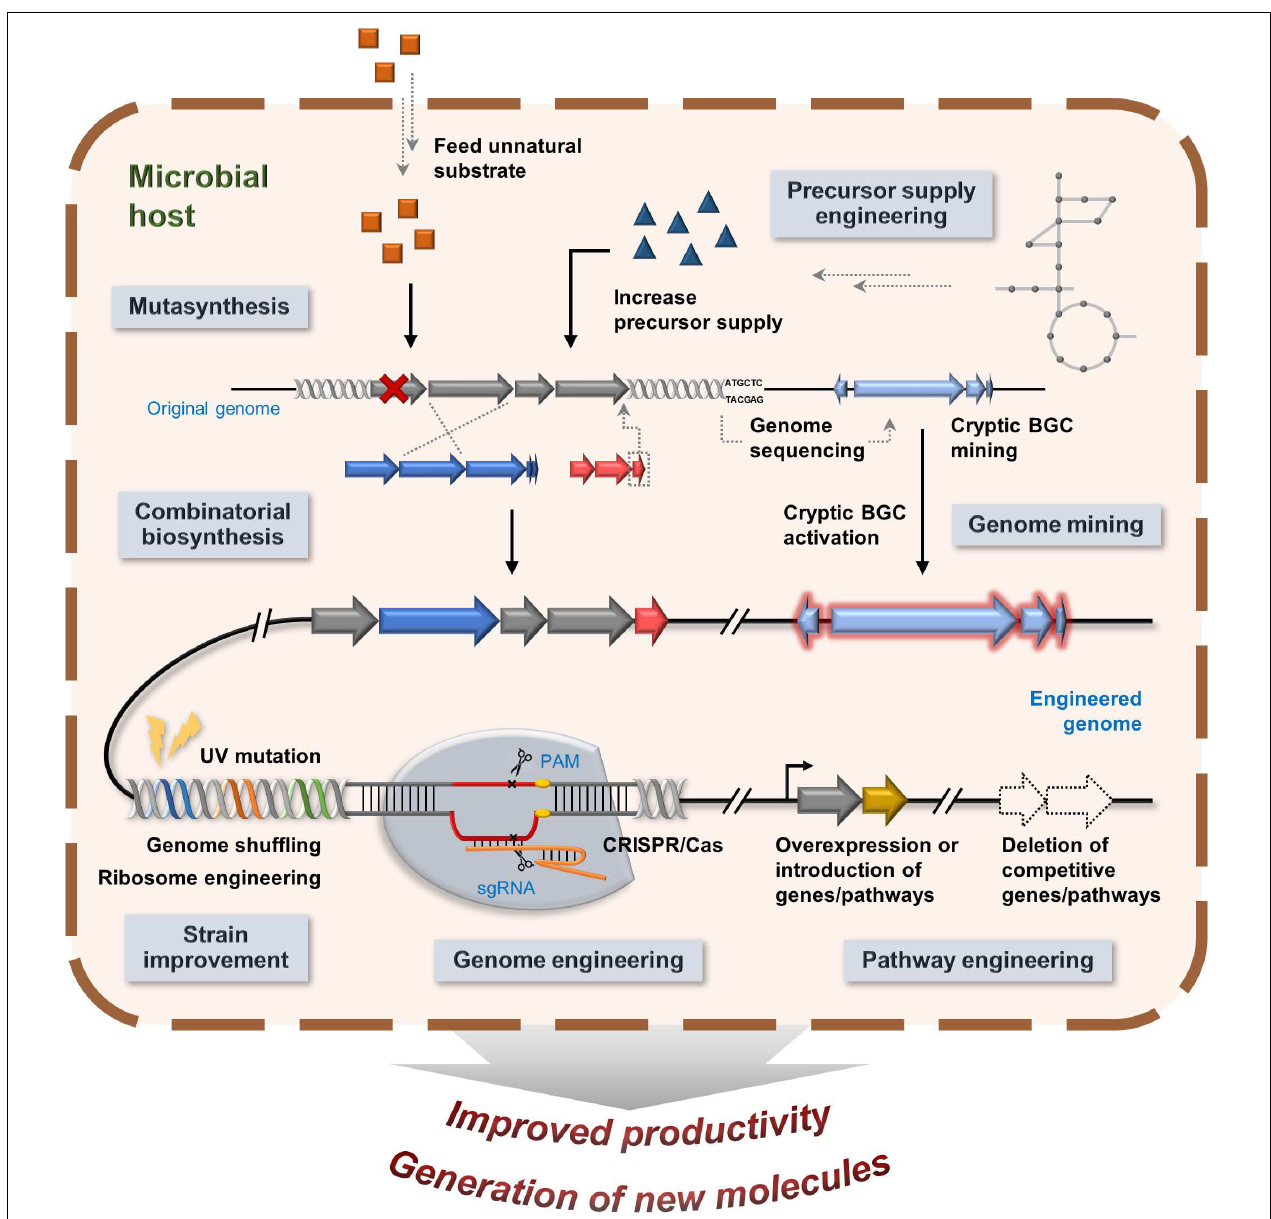
FIGURE 5 | An overview of multiple strategies of product improvements and generation of new